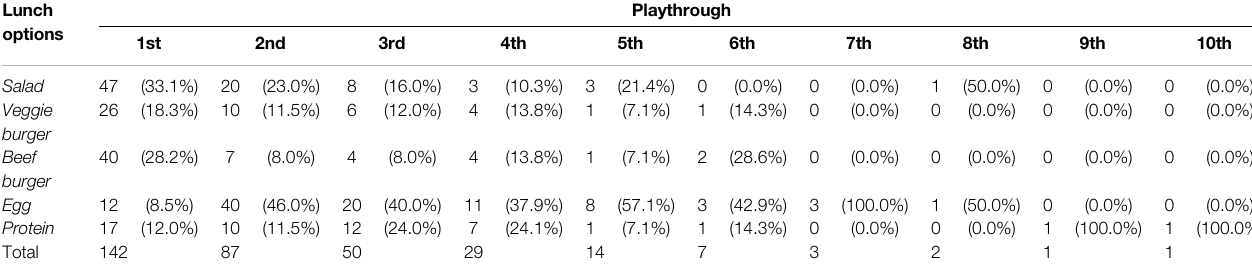
TABLE 4 | Lunch choices by playthrough.